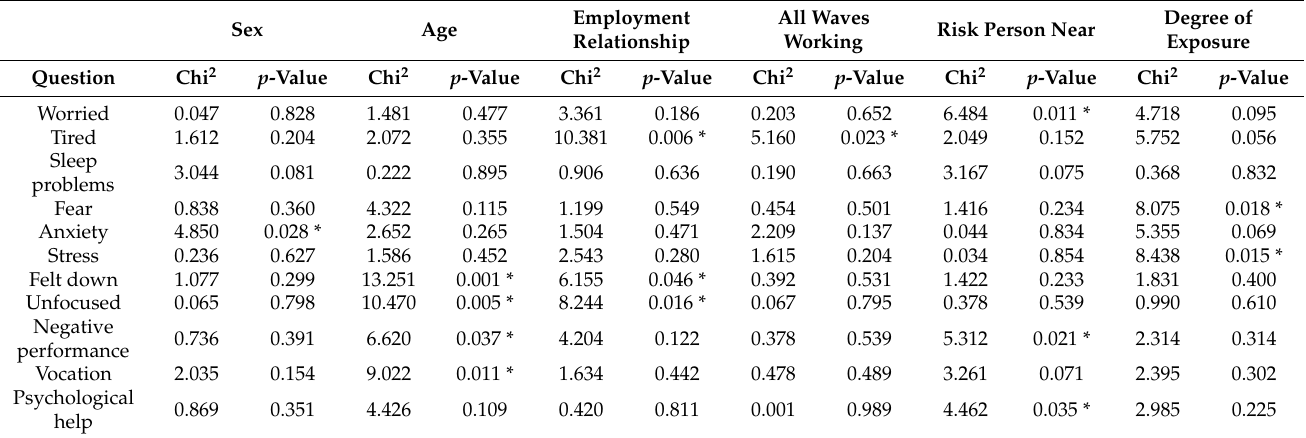
Table 4. Results of chi-square tests comparing grouped and covariate